Question: State the chart type depicted above.
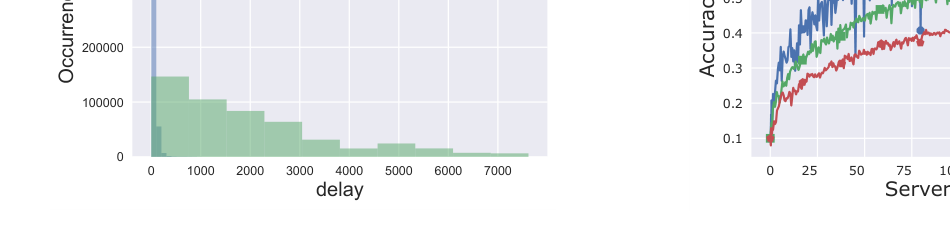
Answer: histogram